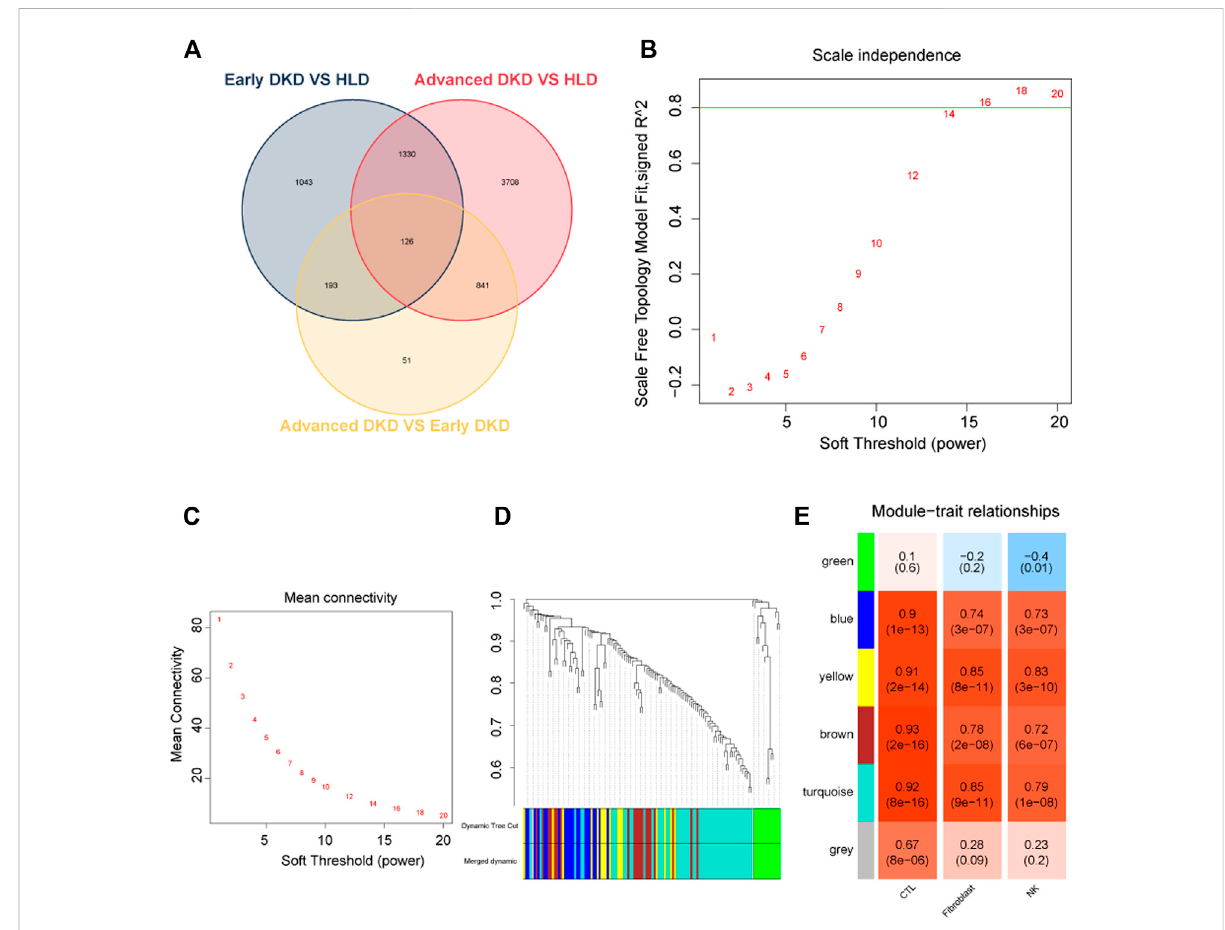
FIGURE 4 Weighted co-expressed network (WGCNA) analysis. (A) Venn diagram for differentially expressed genes. (B) A graph showing the selection of a soft threshold. (C) Under different soft thresholds, the mean connectivity of genes is calculated. (D) The original module (dynamic tree cut) and allocated merged modules (merged dynamic). (E) Module-trait links.Each row correspondstoamoduleeigengene, andthecolumncorrespondsto cytotoxic T lymphocytes (CTLs), fi broblast, natural killer (NK) cells. Correlation and p -value were displayed for each cell subtype. HLD, healthy living donor; DKD, diabetic kidney